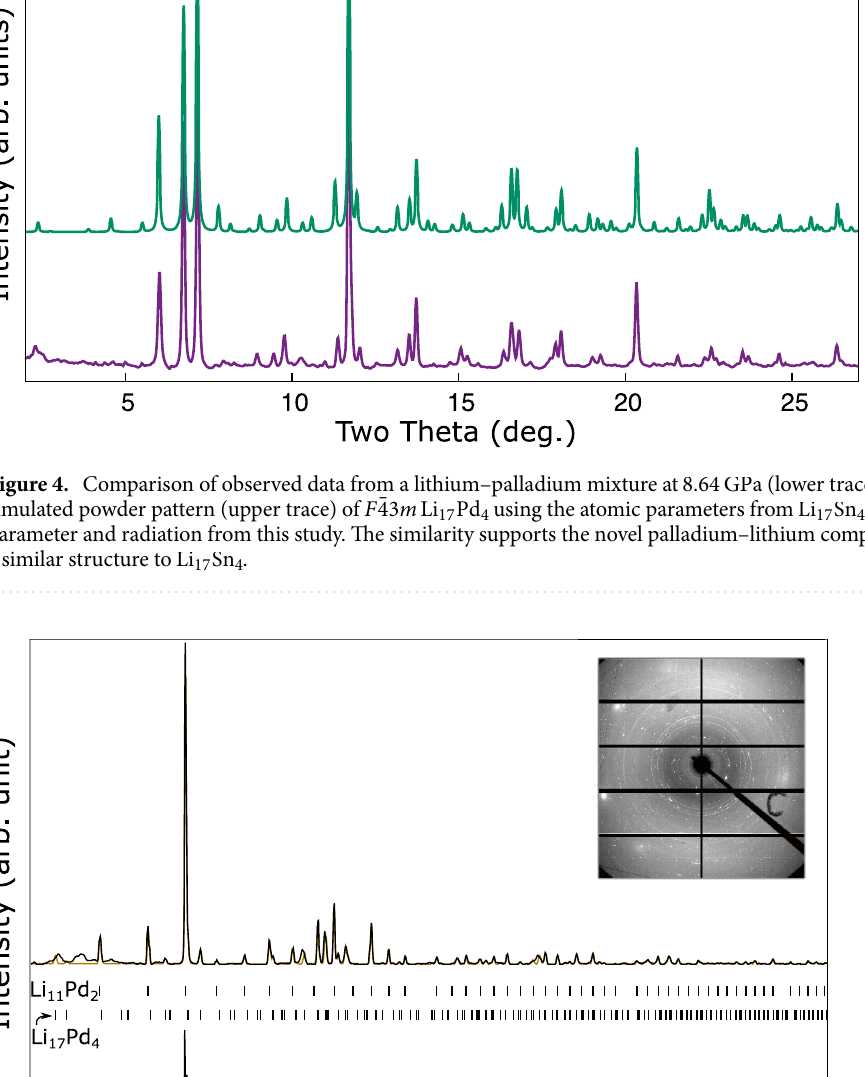
Figure 5. Integrated diffraction pattern of the lithium–palladium intermetallics at 200 with LeBail fit to proposed ambient-temperature F Li 11 Pd 2 ( a = 9.218 Å) phases (orange) and residual on same scale (lower black line). Allowed peak positions for each phase are indicated by ticks. The broad unfitted features at low angle are from the Kapton window of the heater. Inset: Unintegrated diffraction